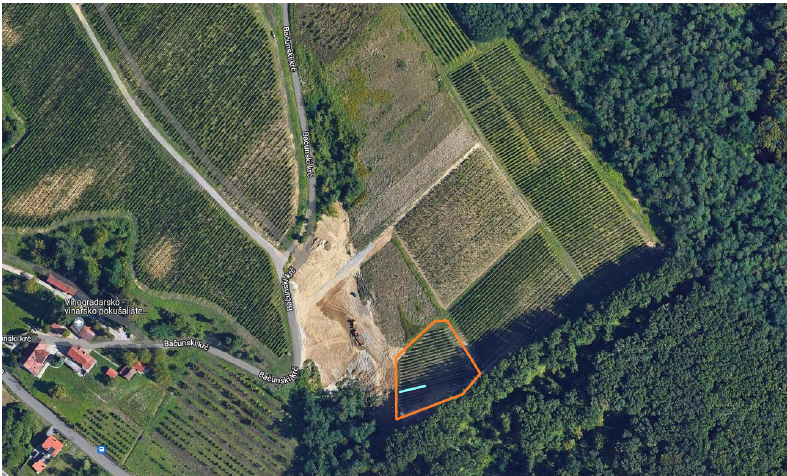
Figure 1. The section of the vineyard chosen to carry out the experiments is indicated in orange in the Jazbina vineyard. In this work, the experiments were carried out in the aisle marked in blue. The Jazbina vineyard is located on an 8% slope with clayey